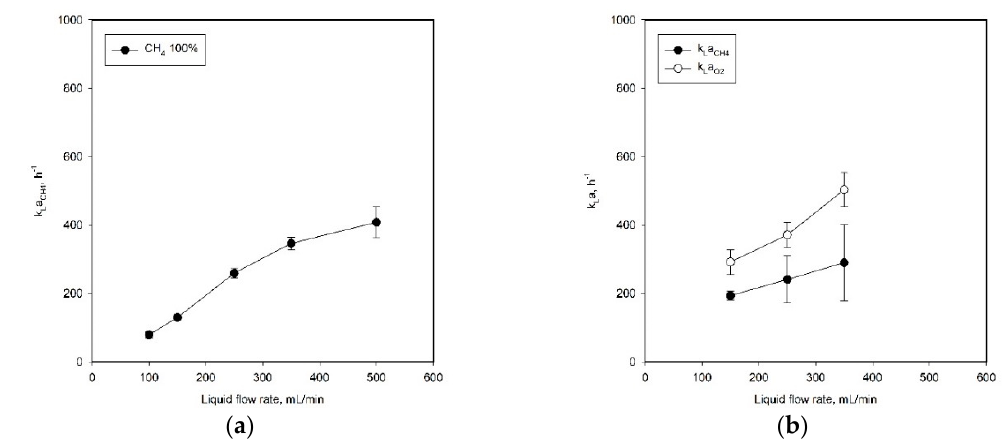
Figure 3. Volumetric mass transfer coefficients for ( a ) methane in the system using 100% methane gas and ( b ) methane (closed circles) and oxygen (open circles) using the gas containing 30% methane and 70% air.